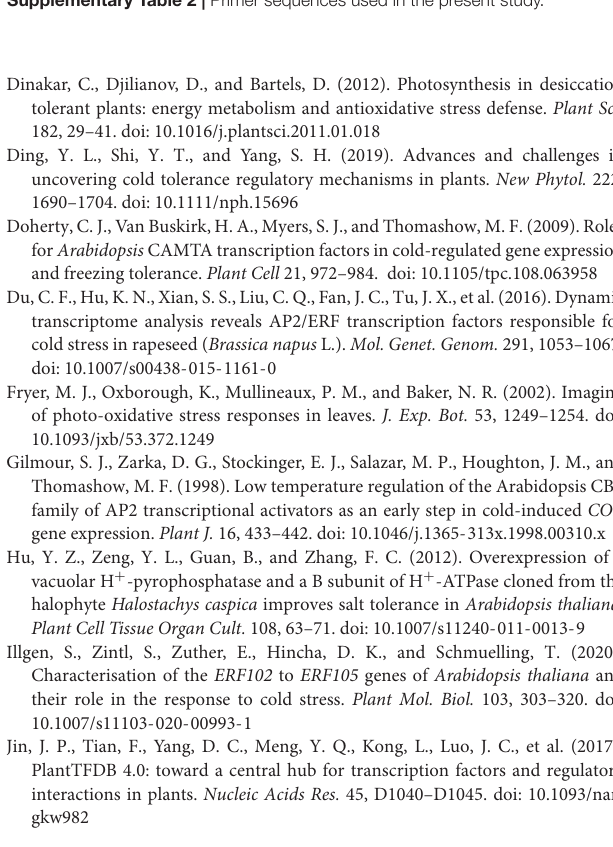
generate phylogenetic tree. Supplementary Table 2 | Primer sequences used in the present